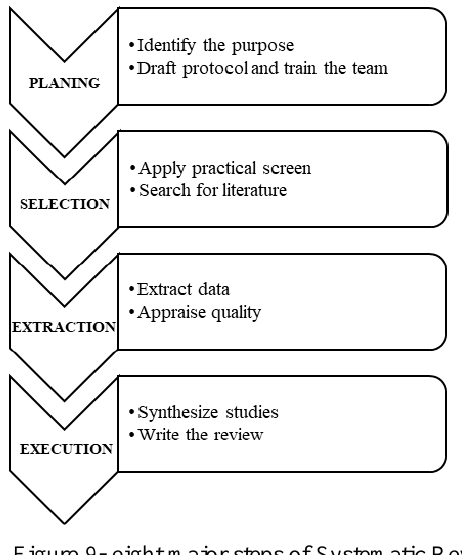
Figure 9- eight major steps of Systematic